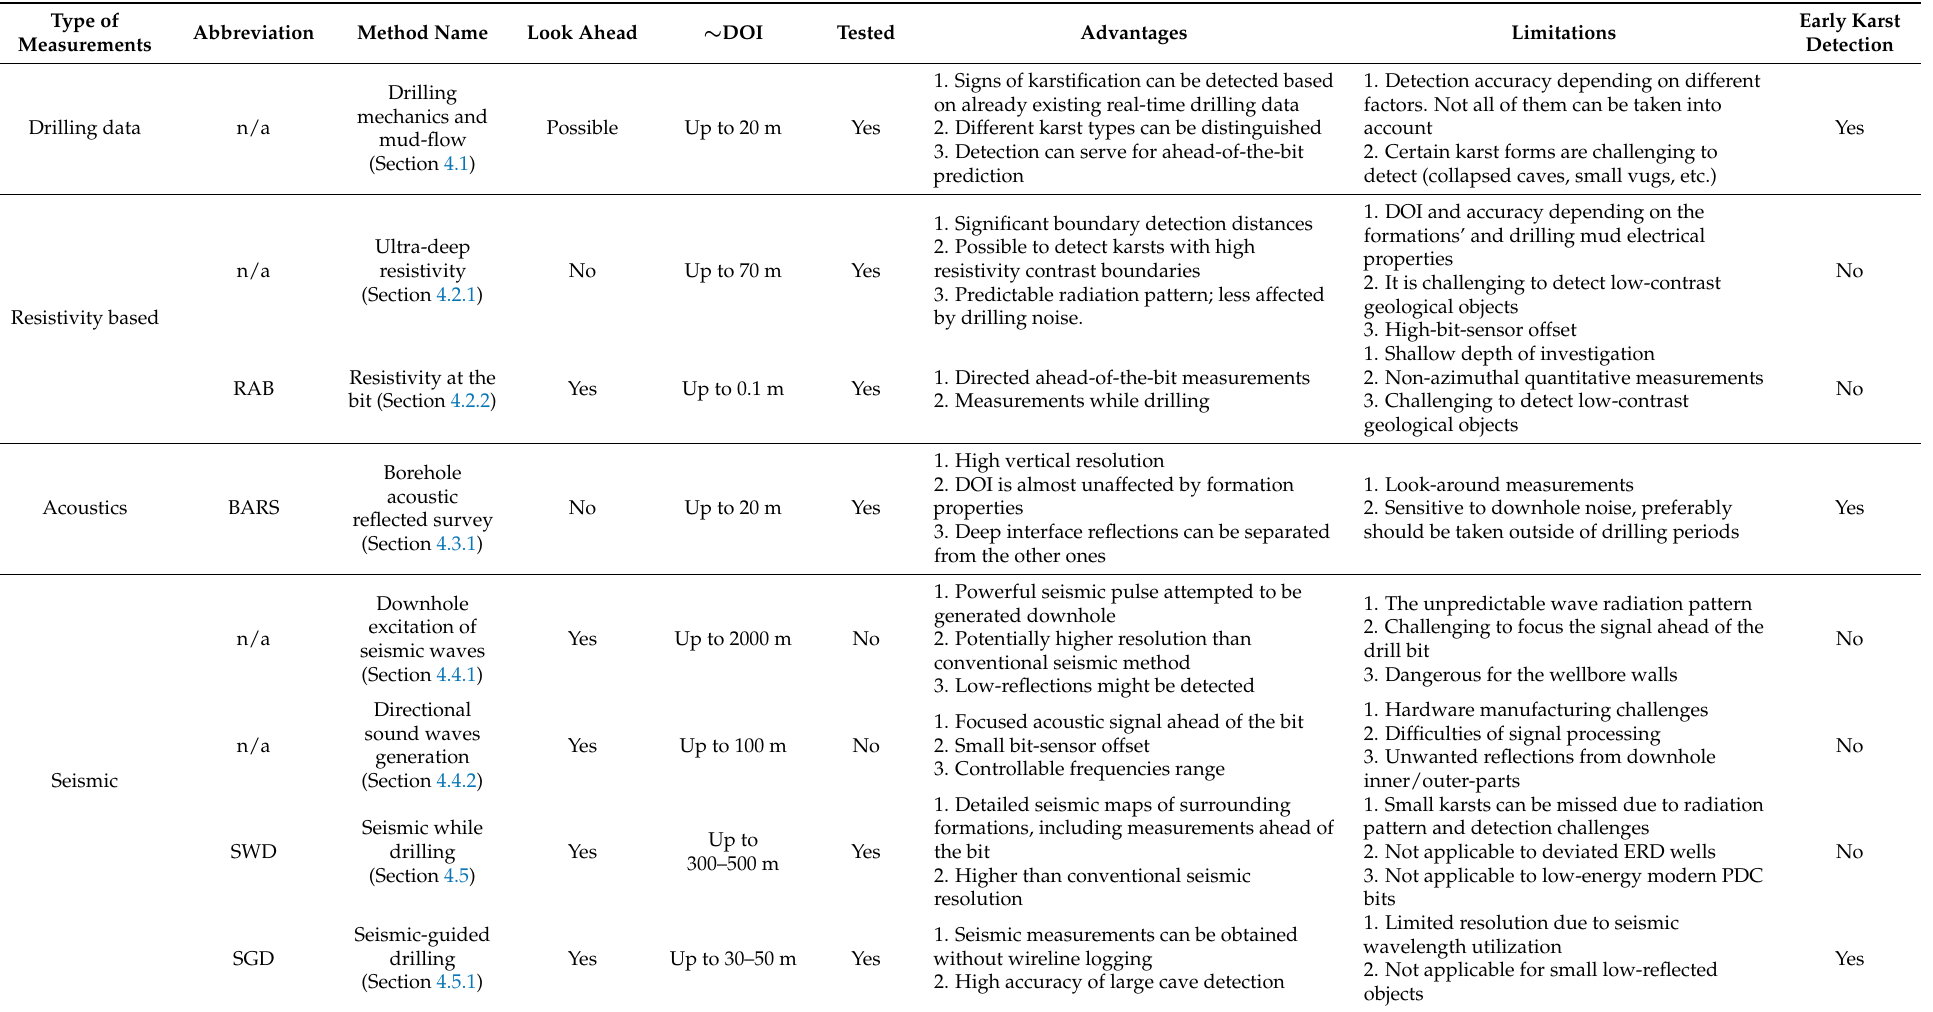
Table 3. Methods of karst detection while